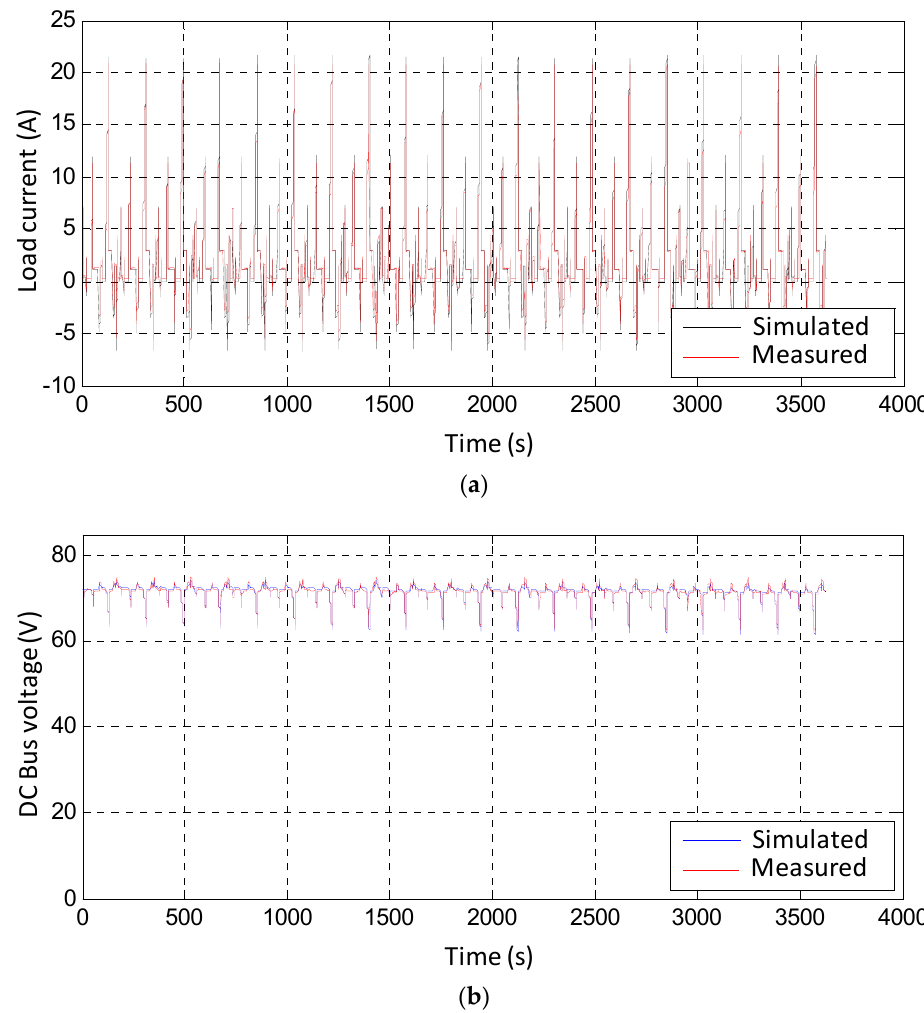
Figure 31. Simulated and measured results of ( a ) demanded current by the load and ( b ) DC bus voltage, during 20 driving cycles.